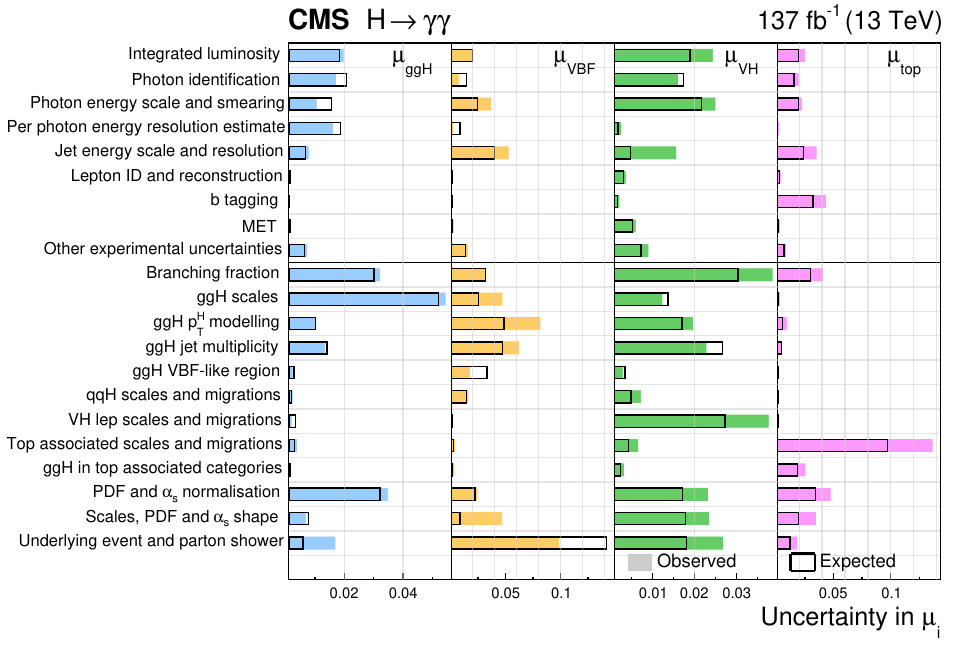
Figure 17 . A summary of the impact of the main sources of systematic uncertainty in the fit to signal strength modifiers of the four principal production modes. The observed (expected) impacts are shown by the solid (empty) bars. The colour scheme is chosen to match the diagram presented in figure